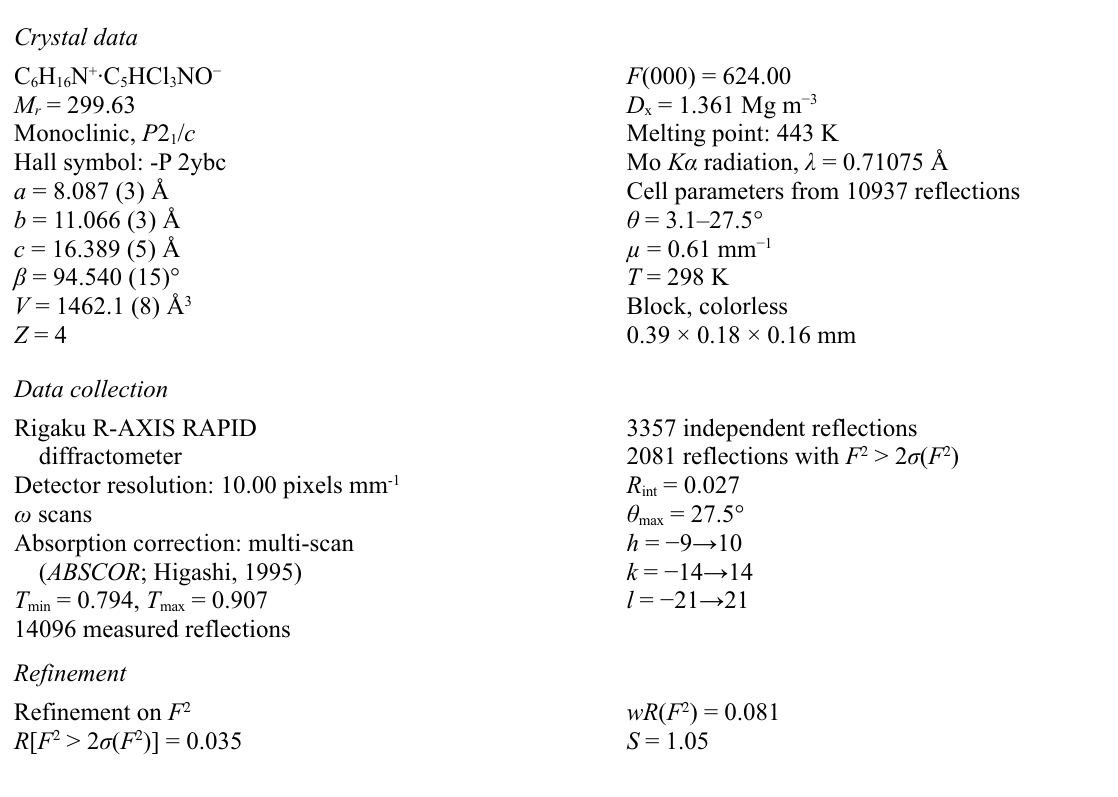
The centrosymmetric hydrogen-bonded (dashed lines) cluster in (I), showing the atom-numbering scheme and 40% probability displacement ellipsoids. [Symmetry code: (i) - x + 1, - y + 1, - z + 1.] Diisopropylammonium